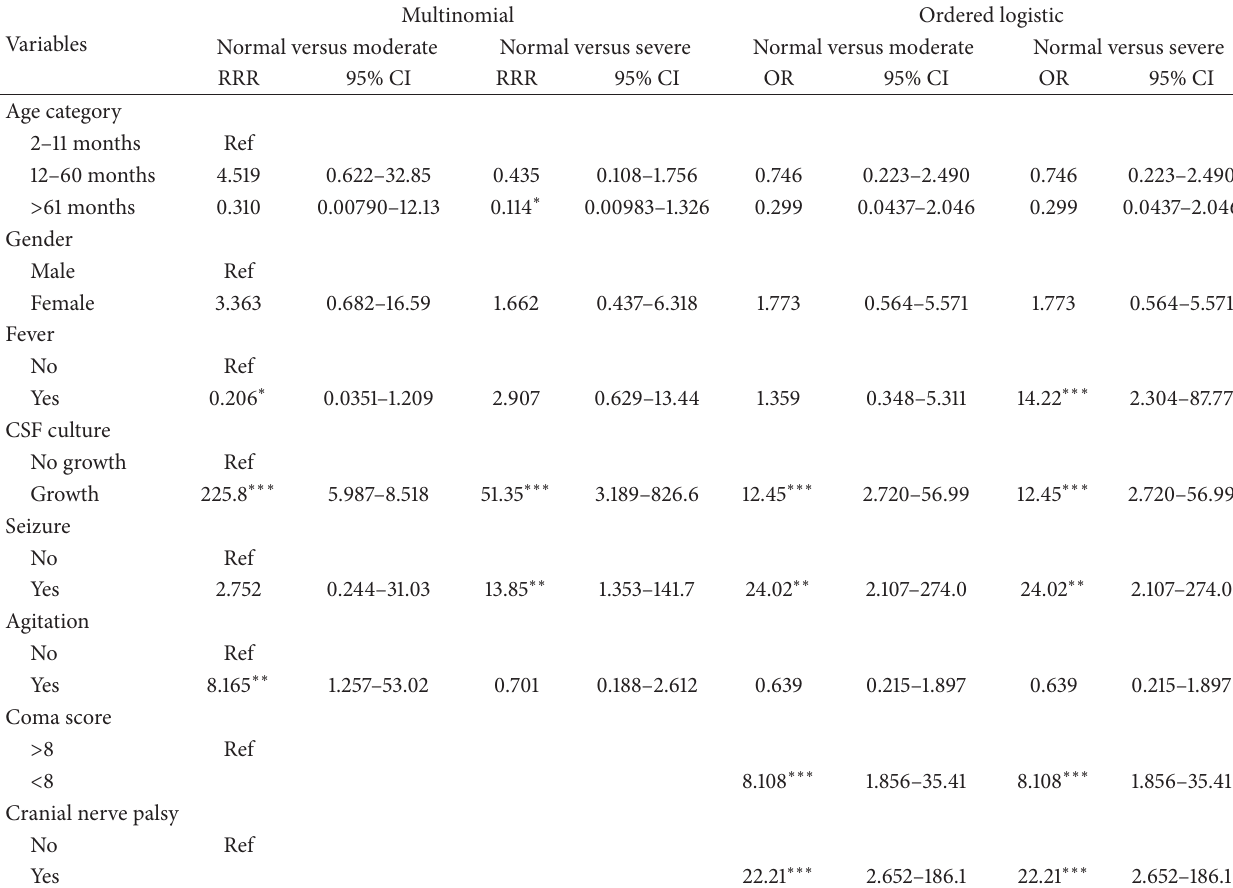
Table 6: Multivariable multinomial and ordered logistic